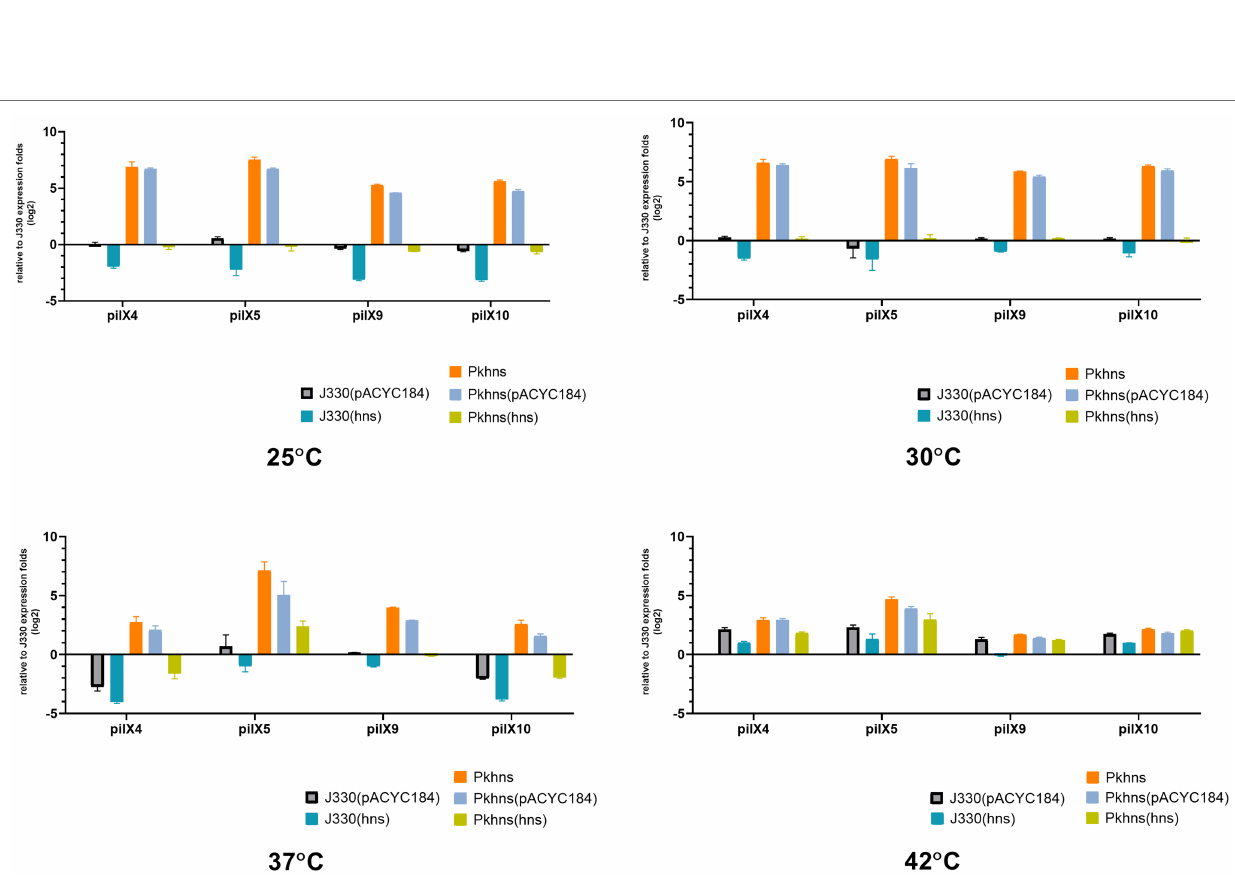
FIGURE 5 | At four different temperatures (25, 30, 37, and 42 ° C), the mRNA expression of T4SS-related gene pilX4, 5, 9, and 10 of six gene context-related strains: J330, Pkhns ( phns -null strains), corresponding phns complementary strains Pkhns(hns), J330(hns), and corresponding blank-vector complementary strains J330(pACYC184), Pkhns(pACYC184)